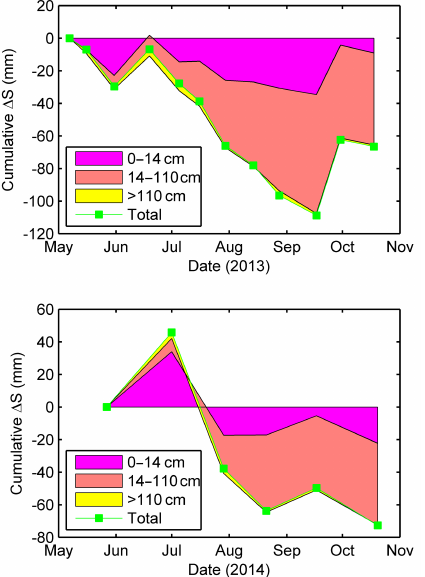
Figure 4. Cumulative change in storage with depth; 0–14cm repre- sents the cosmic-ray neutron probe measurements.